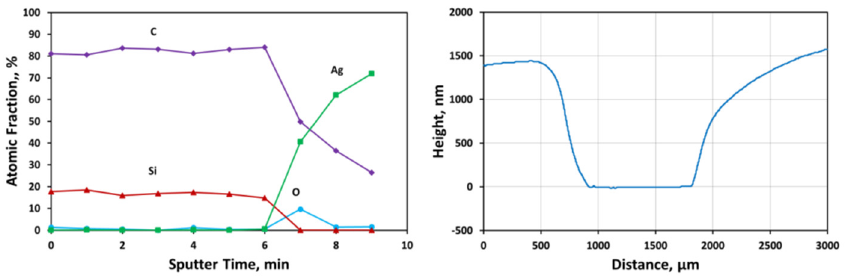
Figure 3. ( left panel ) Composition of PVTMS film on Si-(C, Ag) substrate as a function of 10 keV Ar 2500 + sputter time and ( right panel ) crater profile obtained by 10 keV Ar 2500 + sputter for 9 min.